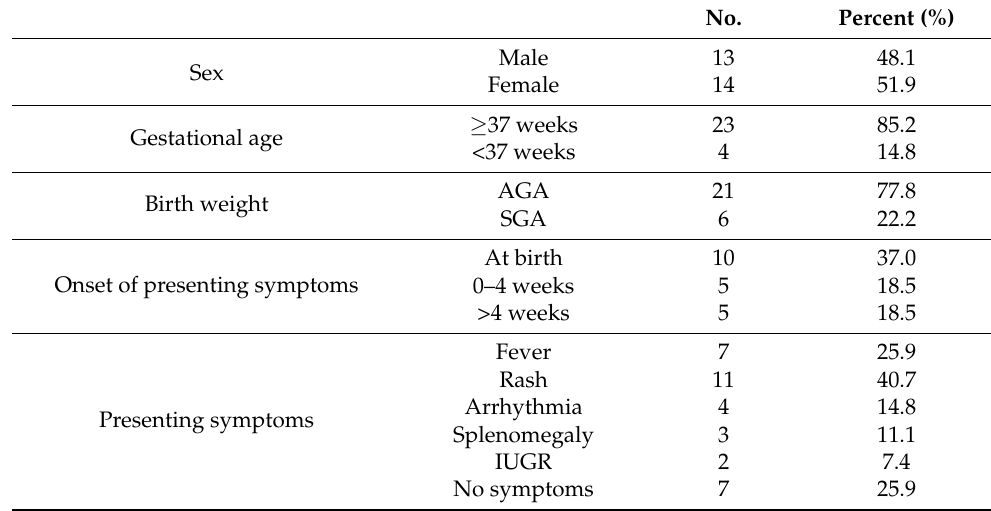
Table 1. Demographics and presenting symptoms of NLE ( n = 27).